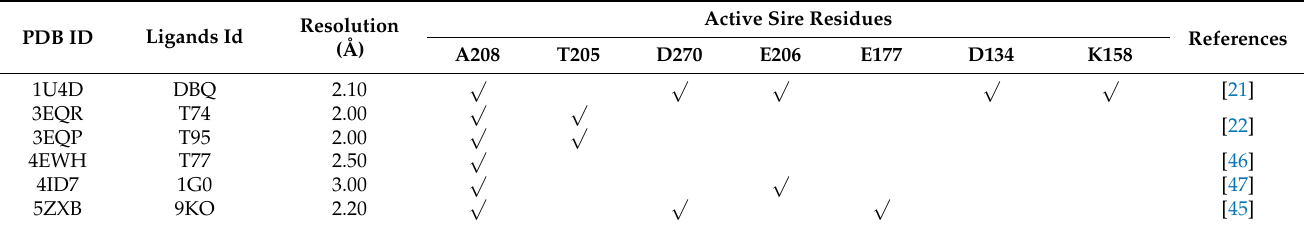
Table 1. Analysis of the binding pattern of inhibitors with ACK1 based on PDB